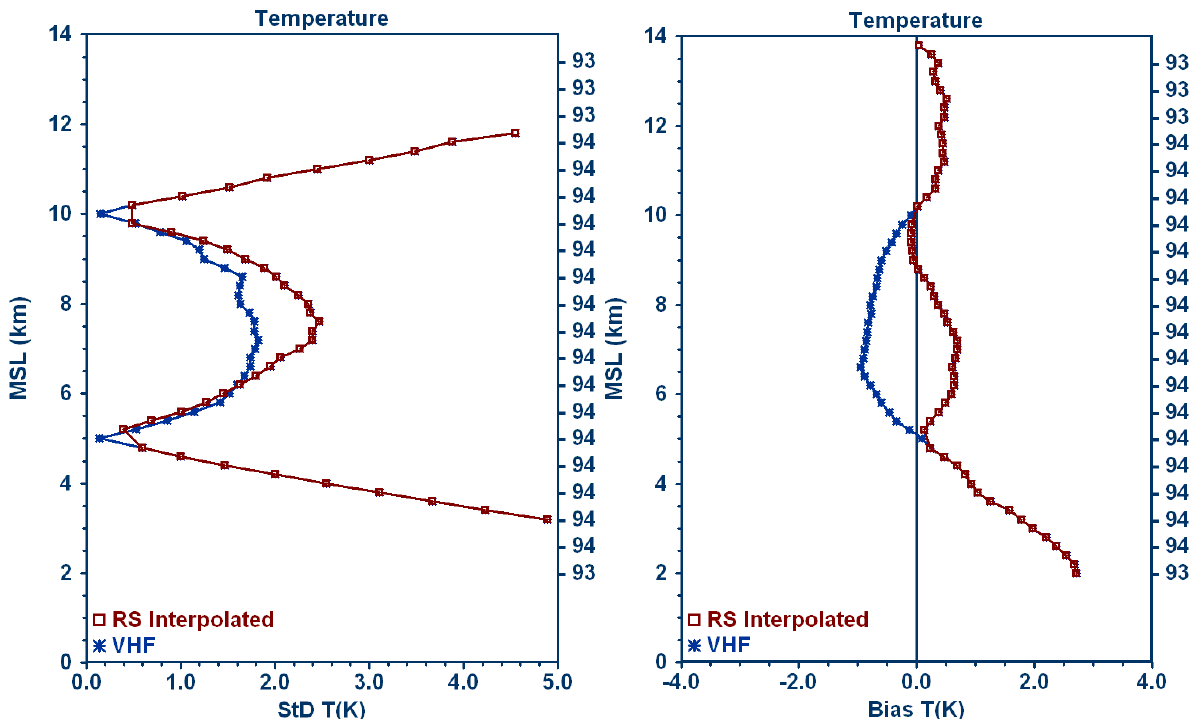
Fig. 6. Standard deviation (a) and bias (b) between radiosonde (RS) temperature measurements and respectively VHF radar temperature computed with the echo power technique (VHF) with reference values between 5 and 10km, and interpolated temperature data from RS between 5 and 10km. The column on the right indicates the number of comparisons used for the